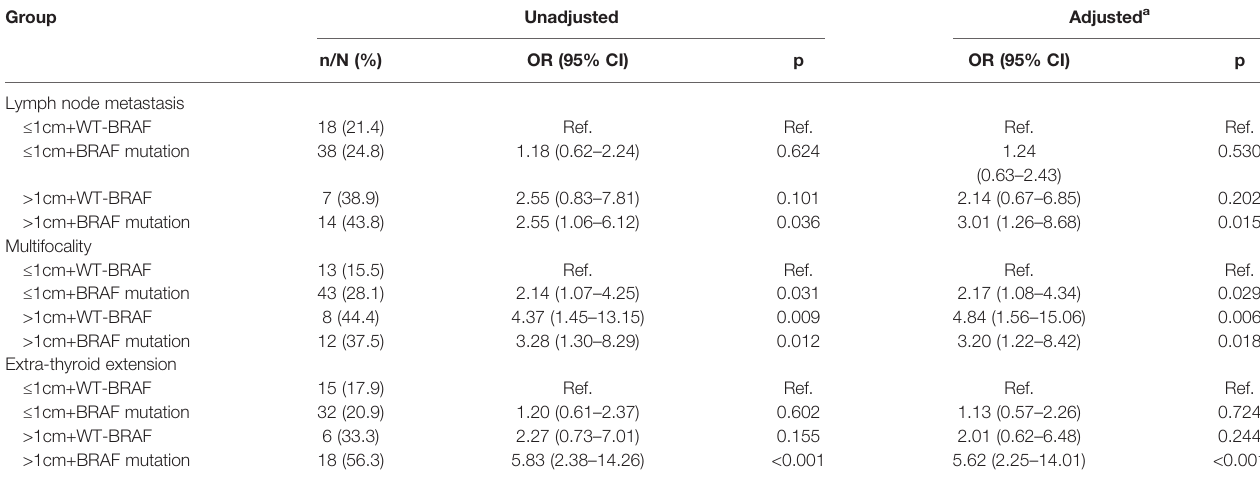
TABLE 5 | The relationship of clinical invasive features and synergistic effect of tumor size and BRAF V600E mutation status by logistic regression analysis.